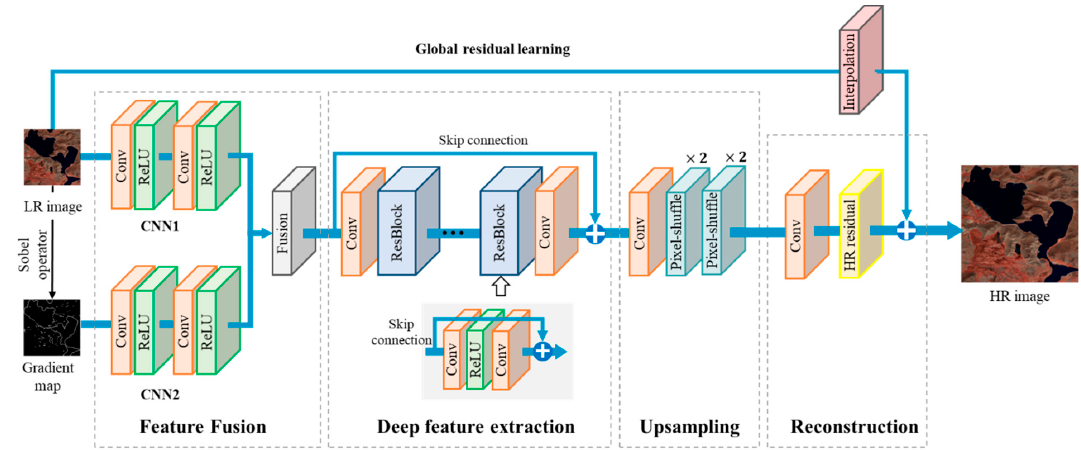
Figure 5. The architecture of the proposed UDGN.